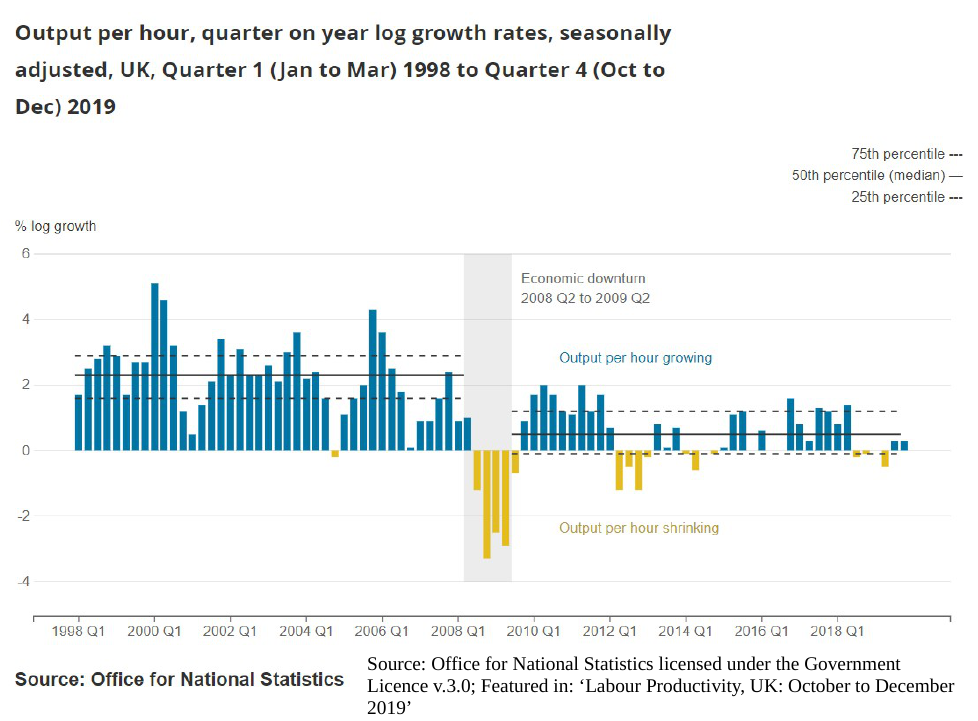
Figure 8. Productivity has remained persistently below its pre-crisis level throughout the decade following the